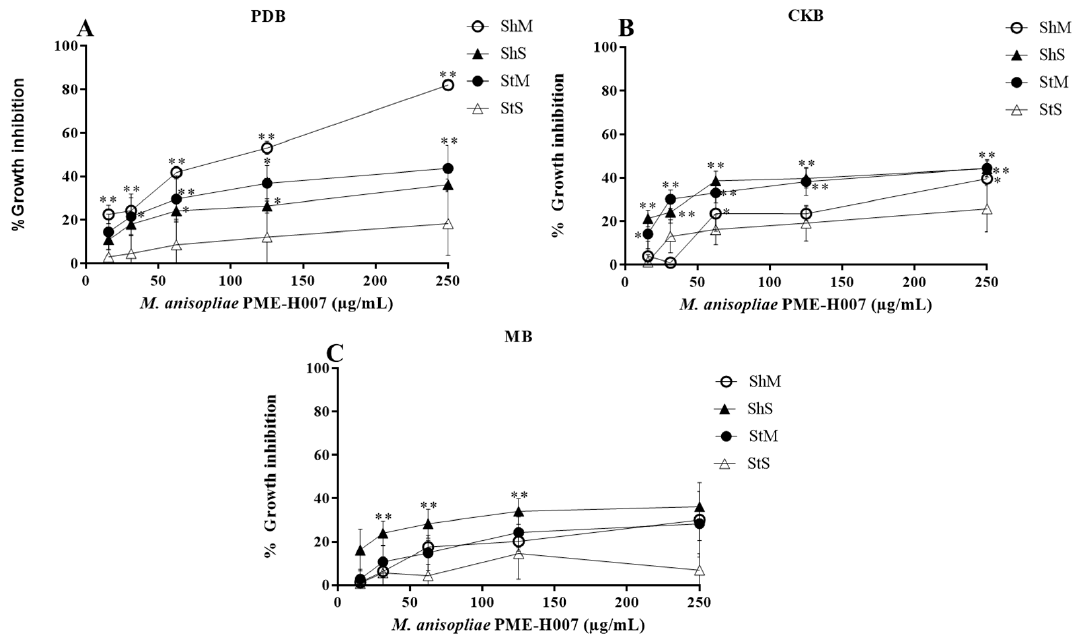
Figure 4. Percentage growth inhibition of M. anisopliae PME-H007 strain methanol extracts against L5178Y-R cells in different media and culture conditions. ( A ) PDB, ( B ) CKB, and ( C ) MB. Data repre- sent the mean ± SD of three replicate determinations from three independent experiments. * p < 0.05, ** p < 0.01, as compared with the untreated control, using the Kruskal–Wallis test. Sh, shaking; St, static; M, mycelium; S, spore.